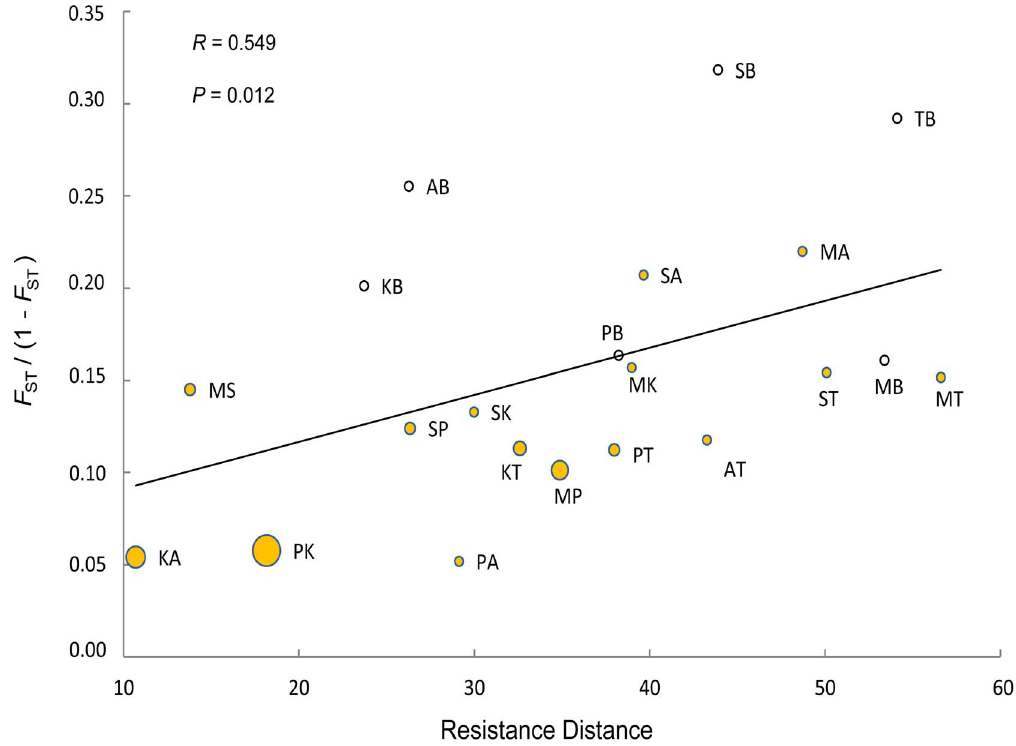
Figure 5. Regression of population pair-wise linearized F ST values with corridor cost. The size of each circle is representative of the proportion of migrants shared between each population pair. Depicted corridors are Kanha-Bandhavgarh (KB), Kanha-Achanakmar (KA), Pench-Kanha (PK), Melghat-Kanha (MK), Satpura-Kanha (SK), Satpura-Pench (SP), Melghat-Pench (MP), Melghat-Satpura (MS), Kanha-Tadoba (KT), Pench- Achanakmar (PA), Melghat-Achanakmar (MA), Achanakmar-Bandhavgarh (AB), Pench-Bandhavgarh (PB), Satpura-Bandhavgarh (SB) and Melghat- Bandhavgarh (MB).